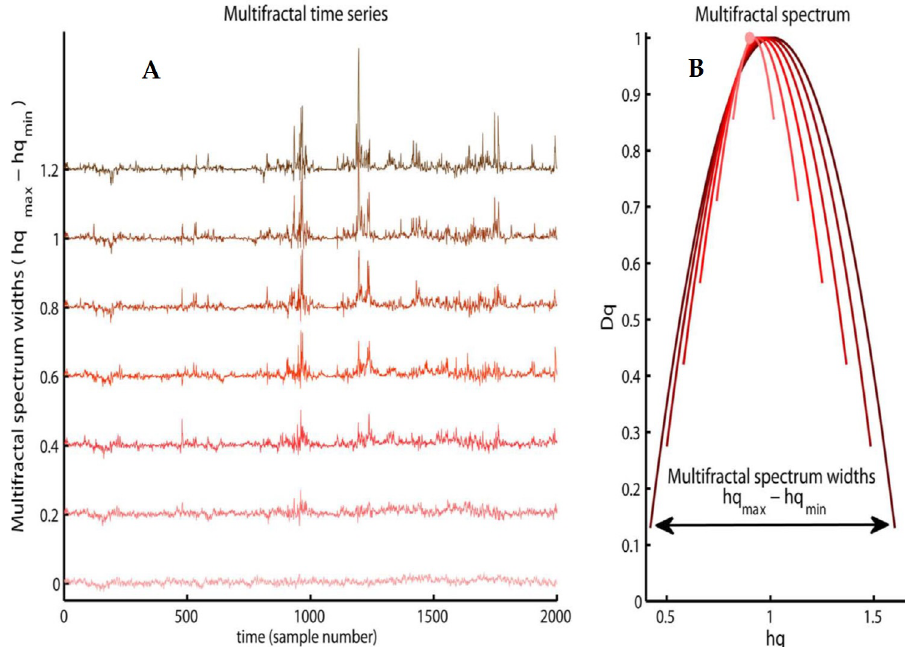
Figure 3. The analysis of the multifractal and continuous time series with the same order q-Hurst q = 2 but with different multifractal spectra: ( A ) calculation with small fluctuations, ( B ) calculation with large fluctuations.